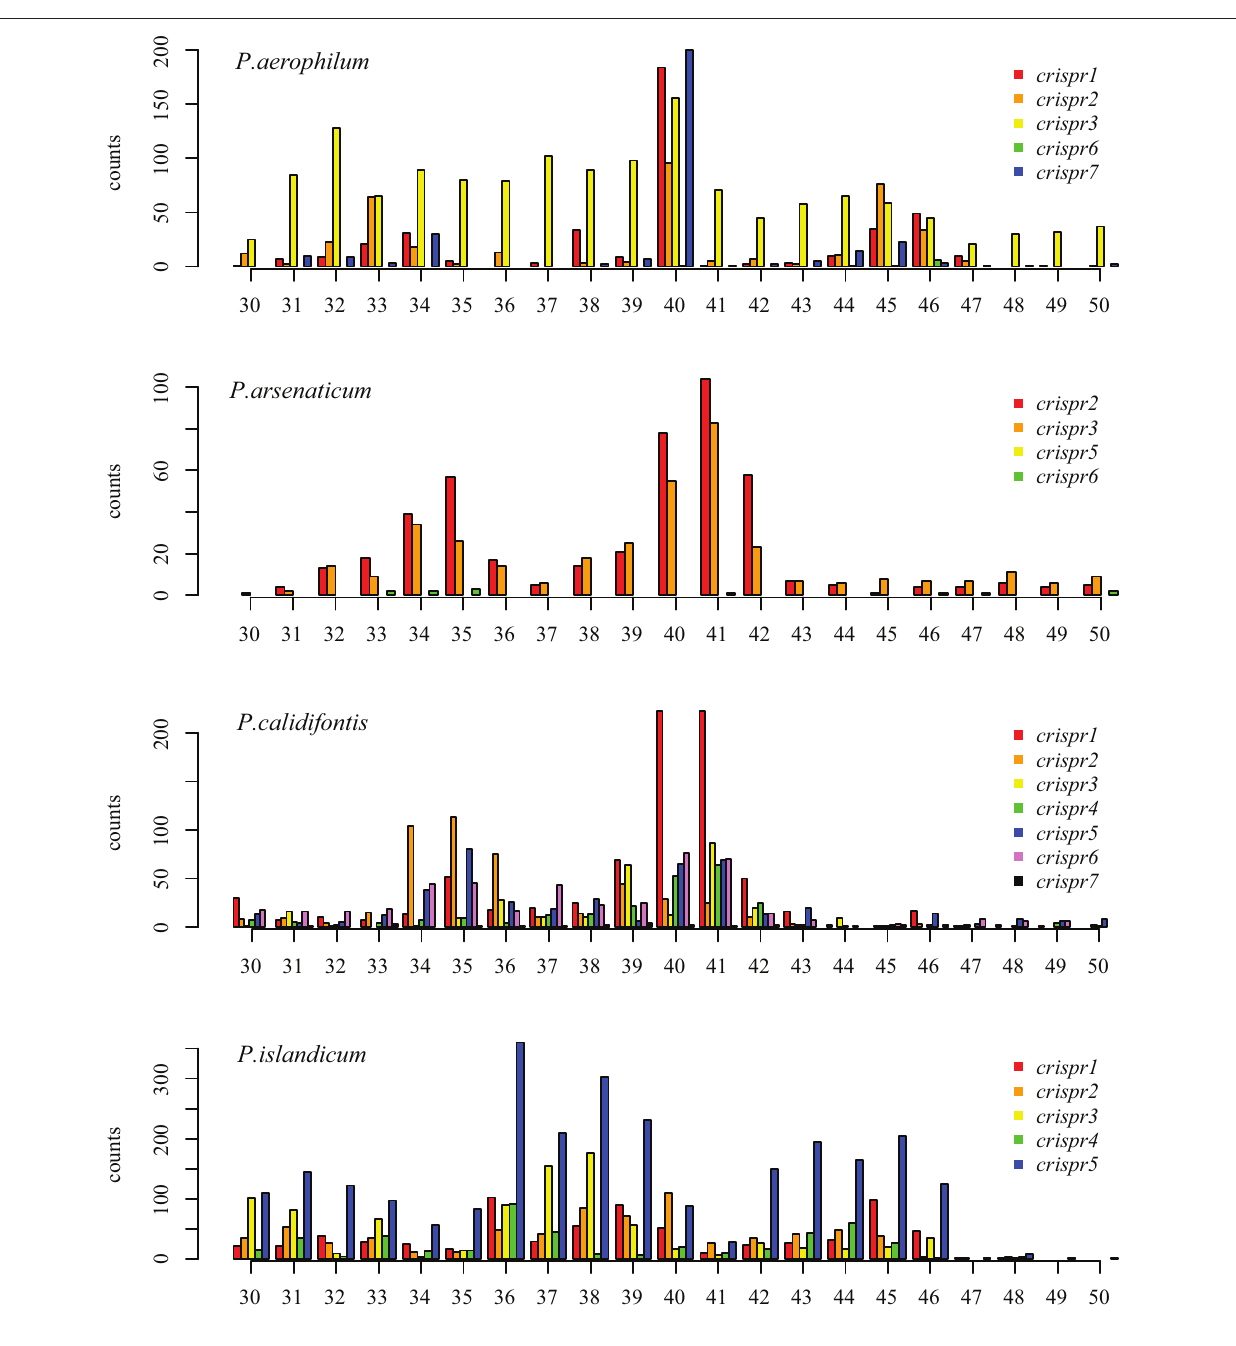
FIGURE A2 | Distribution of mapped 3 (cid:2) ends of crRNA associated sequencing reads, relative to the 5 (cid:2) end of the associated spacer. This model proposes that cleavage of the 3 (cid:2) end of crRNA associated reads utilizes a ruler-mechanism measured from the upstream DR. In P. aerophilum , P. arsenaticum, and P. calidifontis , the majority population of crRNA